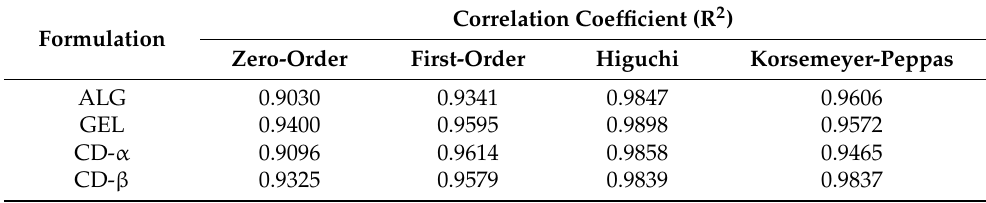
Table 4. The correlation coefficients obtained by fitting the release data in different kinetical models.